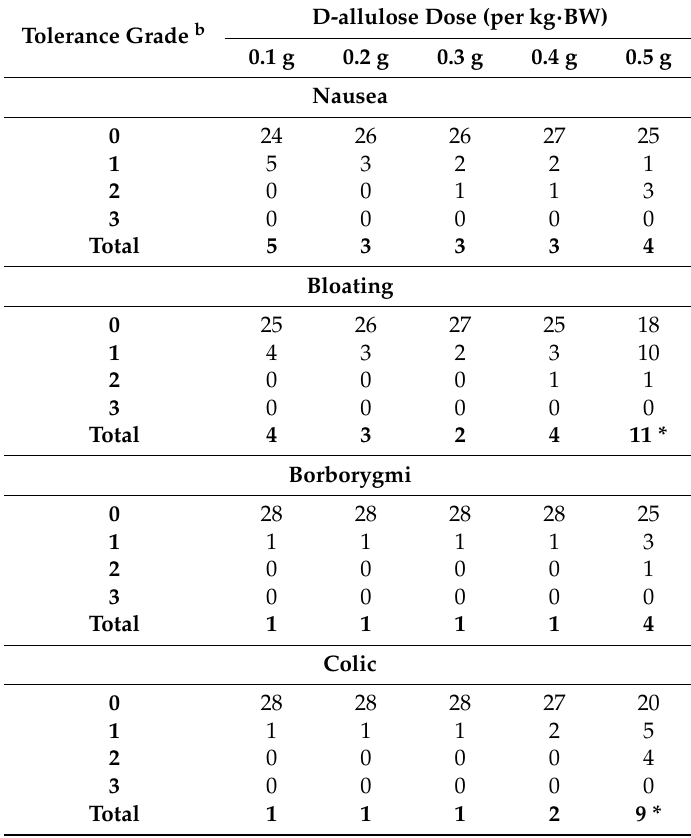
Table 6. GI symptoms in the 24 h following the consumption of test drinks containing D-allulose, for occasional ingestion (number of subjects reporting symptoms, n = 29 a